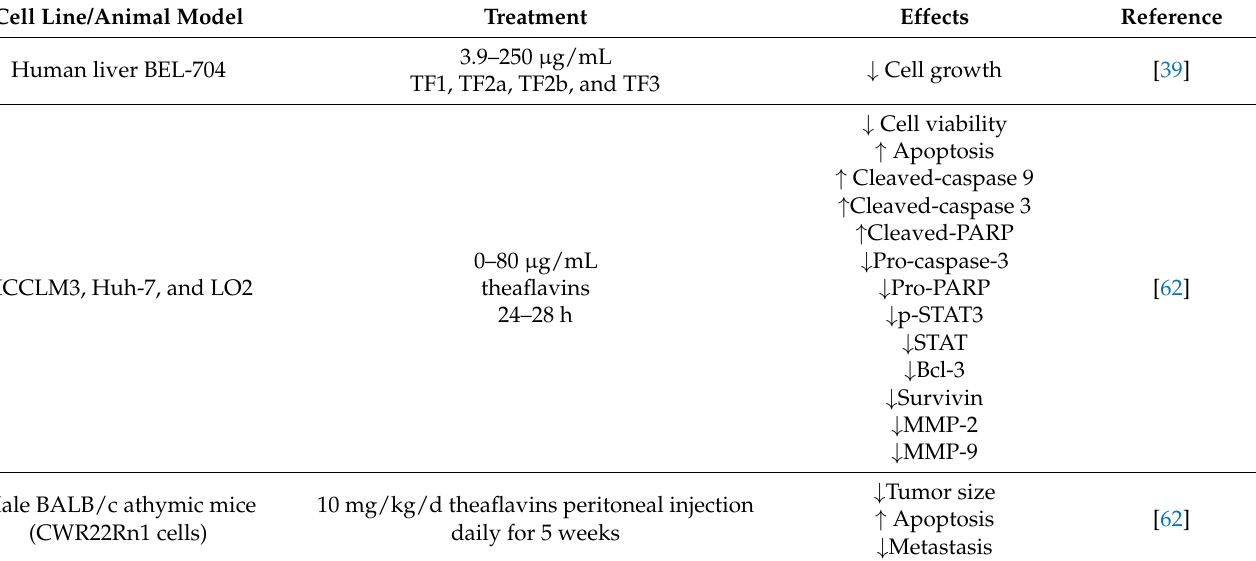
Table 9. Effects of theaflavins in liver